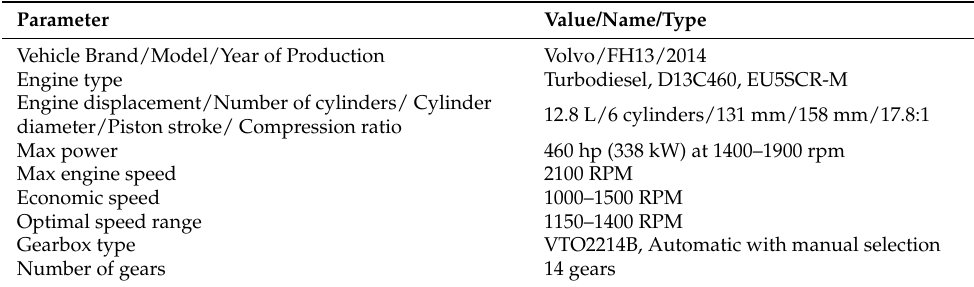
Table 2. Selected factory technical data of the tested vehicle [12].